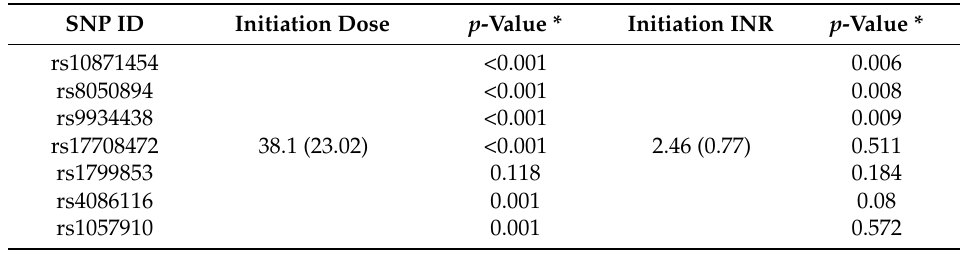
Table 4. Association of VKORC1 and CYP2C9 SNPs with variability on warfarin required doses and with INR treatment